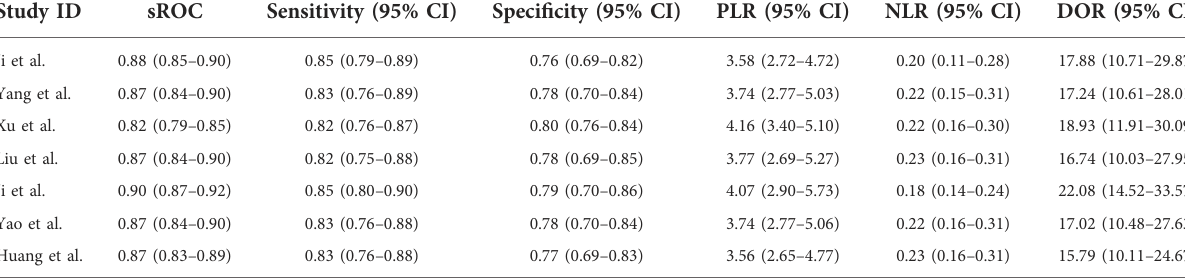
TABLE 4 The results of sensitivity analyses for each study.